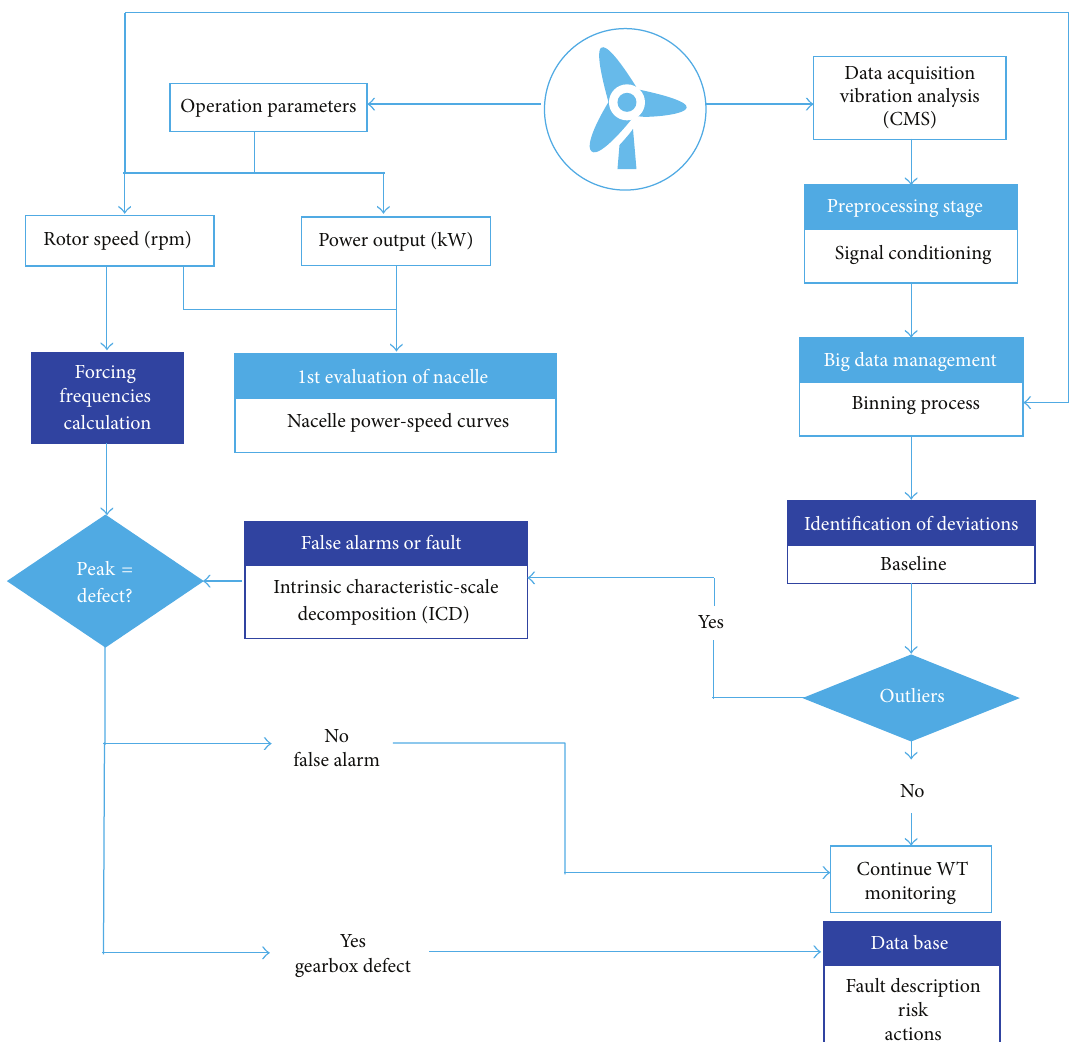
Figure 2: Flow chart of a novel condition monitoring algorithm for gearbox fault